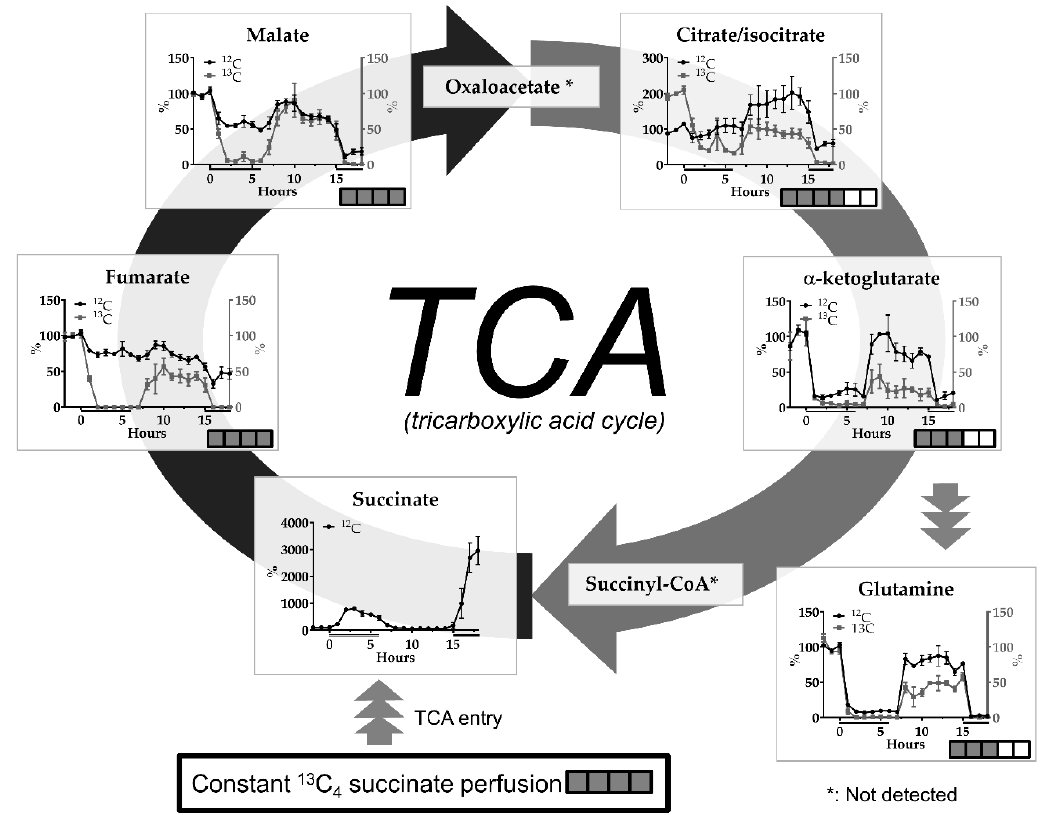
Figure 2. Effects of perfusion with 10 mM (0–6 h) or 50 mM malonate (14–18 h) on interstitial levels of endogenous ( 12 C) and 13 C-labeled tricarboxylic acid cycle (TCA) metabolites succinate, fumarate, malate, isocitrate, alpha-ketoglutarate and related glutamine upon constant perfusion with 1 mM 13 C 4 succinate. Data are mean +/ − SEM of 5 rats and expressed as % change of baseline abundance. The number of 13 C or 12 C atoms in the different metabolites after uptake of 13 C 4 succinate and one turn of the TCA cycle is indicated with the number of filled or open squares. Black bars under the x-axis illustrate time periods of malonate administration. * not detected.